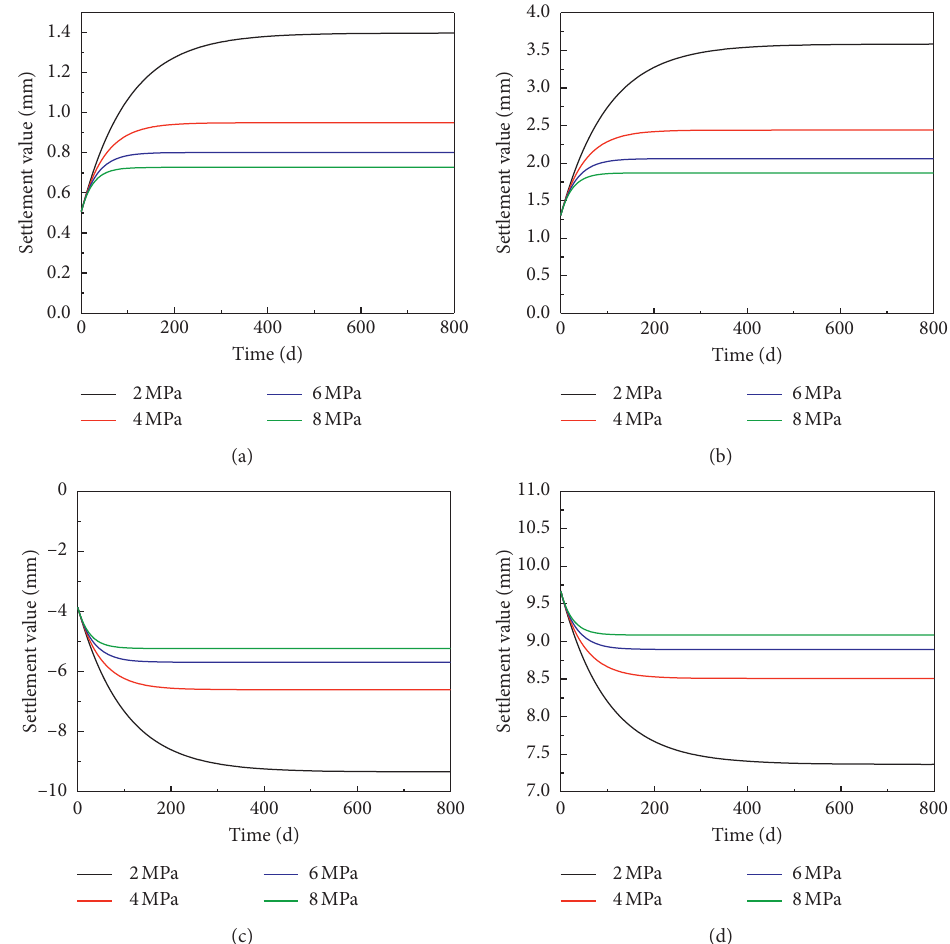
Figure 7: Different shear moduli, G − 10, 0, 10) with time under the action of the support k , cause a change in the settlement value at point ( pressures (a), shield shell frictions (b), grouting pressures (c), and total displacement over time